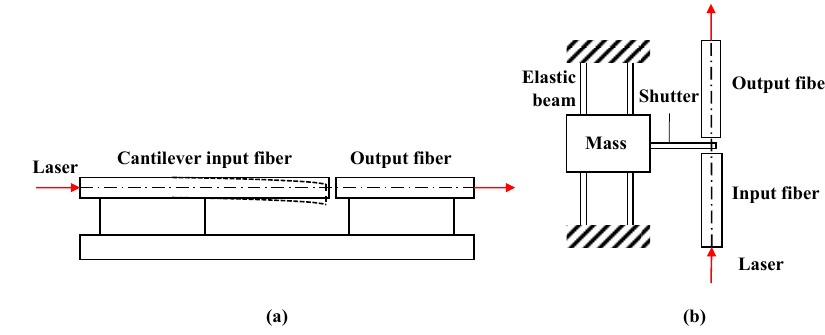
Figure 9. OWG accelerometer: ( a ) cantilever type and ( b ) shutter type.